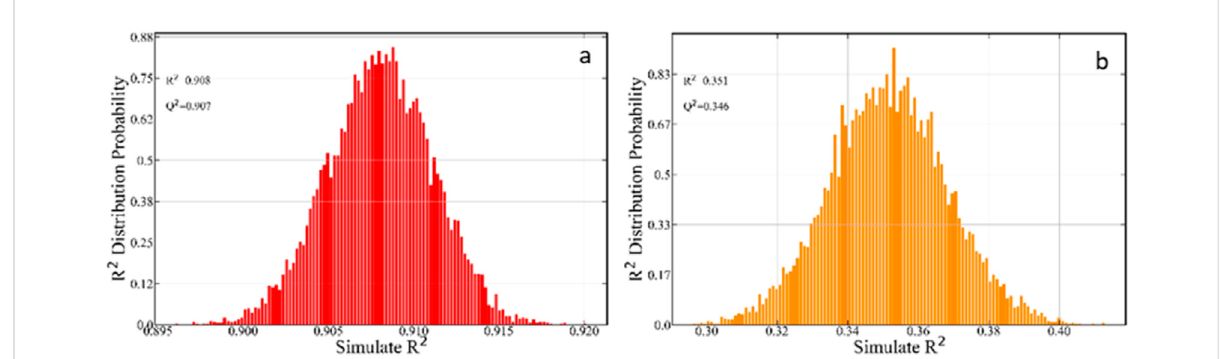
FIGURE 5 The results of 10,000 times Monte Carlo simulation based on the t distribution of the mean squared errors of the baseline component (A) and short-term component (B) regression models in the